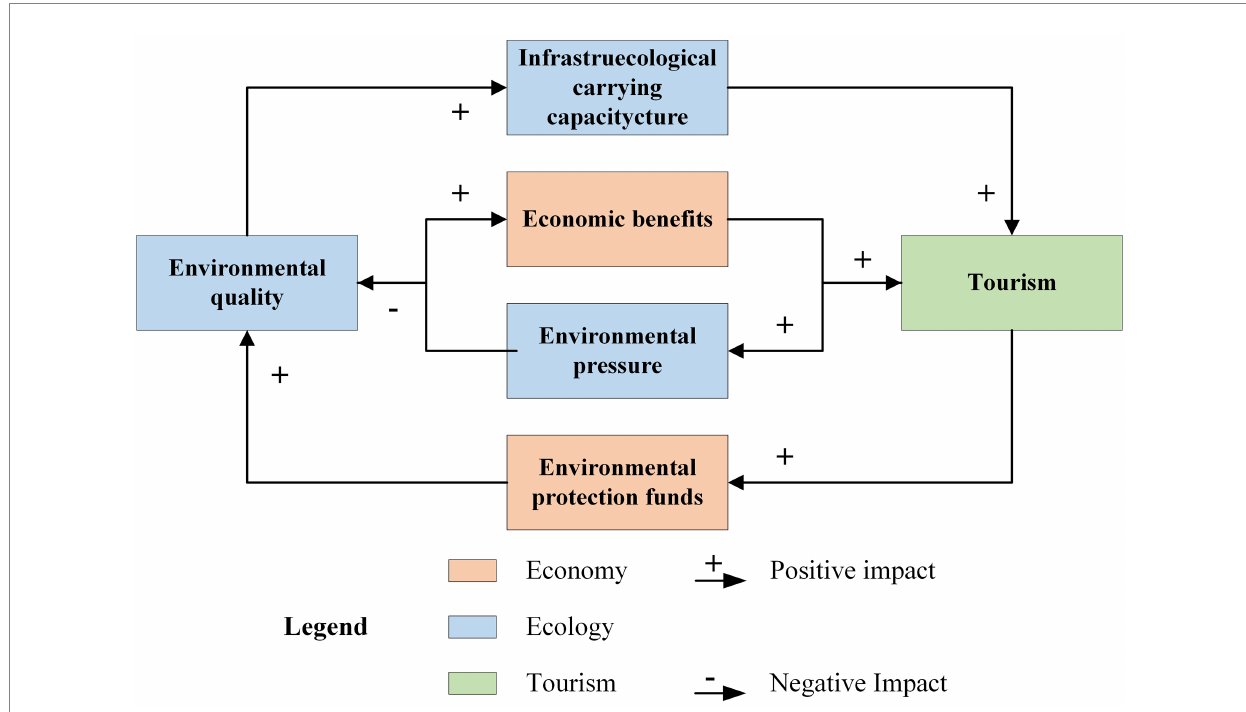
FIGURE 2 Feedback process of ecological environment elements to tourism economic